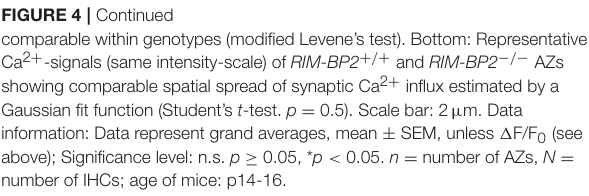
FIGURE 4 | Continued comparable within genotypes (modified Levene’s test). Bottom: Representative Ca 2 + -signals (same intensity-scale) of RIM-BP2 + / + and RIM-BP2 − / − AZs showing comparable spatial spread of synaptic Ca 2 + influx estimated by a Gaussian fit function (Student’s t -test. p = 0.5). Scale bar: 2 µ m. Data information: Data represent grand averages, mean ± SEM, unless 1 F/F 0 (see above); Significance level: n.s. p ≥ 0.05, * p < 0.05. n = number of AZs, N = number of IHCs; age of mice: